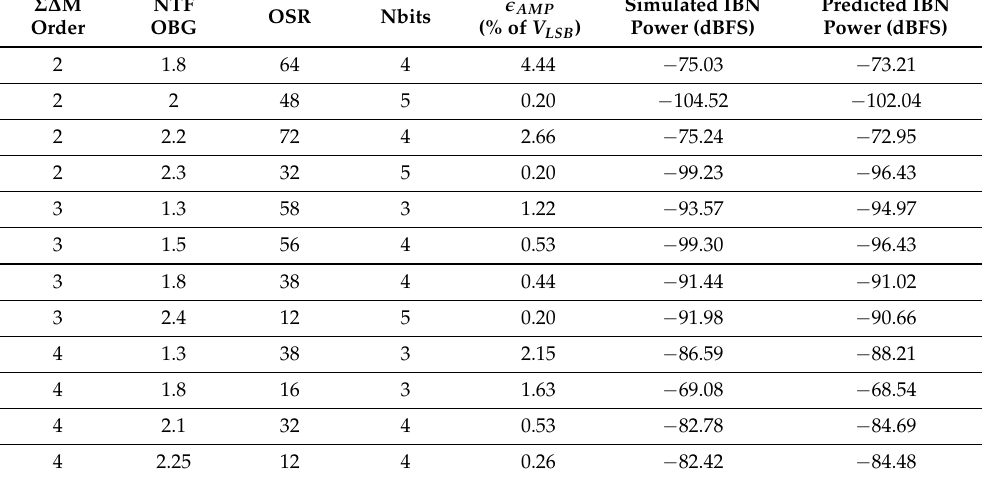
Table 1. Comparison between simulated and predicted IBN power in NP regions due to amplifier linearity